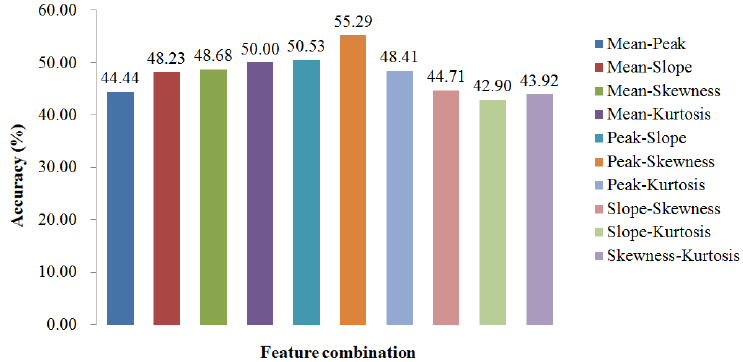
Fig. 7. Classi¯cation accuracies of various feature combinations (averaged over 14